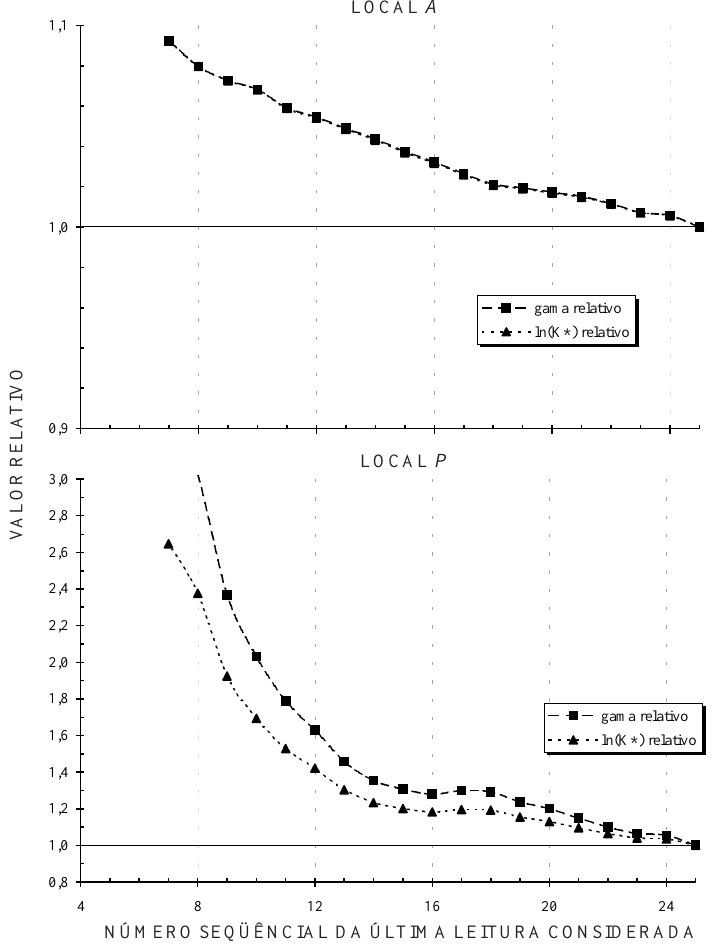
Figura 5. Valores de ggggg e ln(K * ) relativos, respectivamente, aos valores de ggggg realizadas até determinado número seqüencial no local A e no local P (no local A , as duas linhas estão